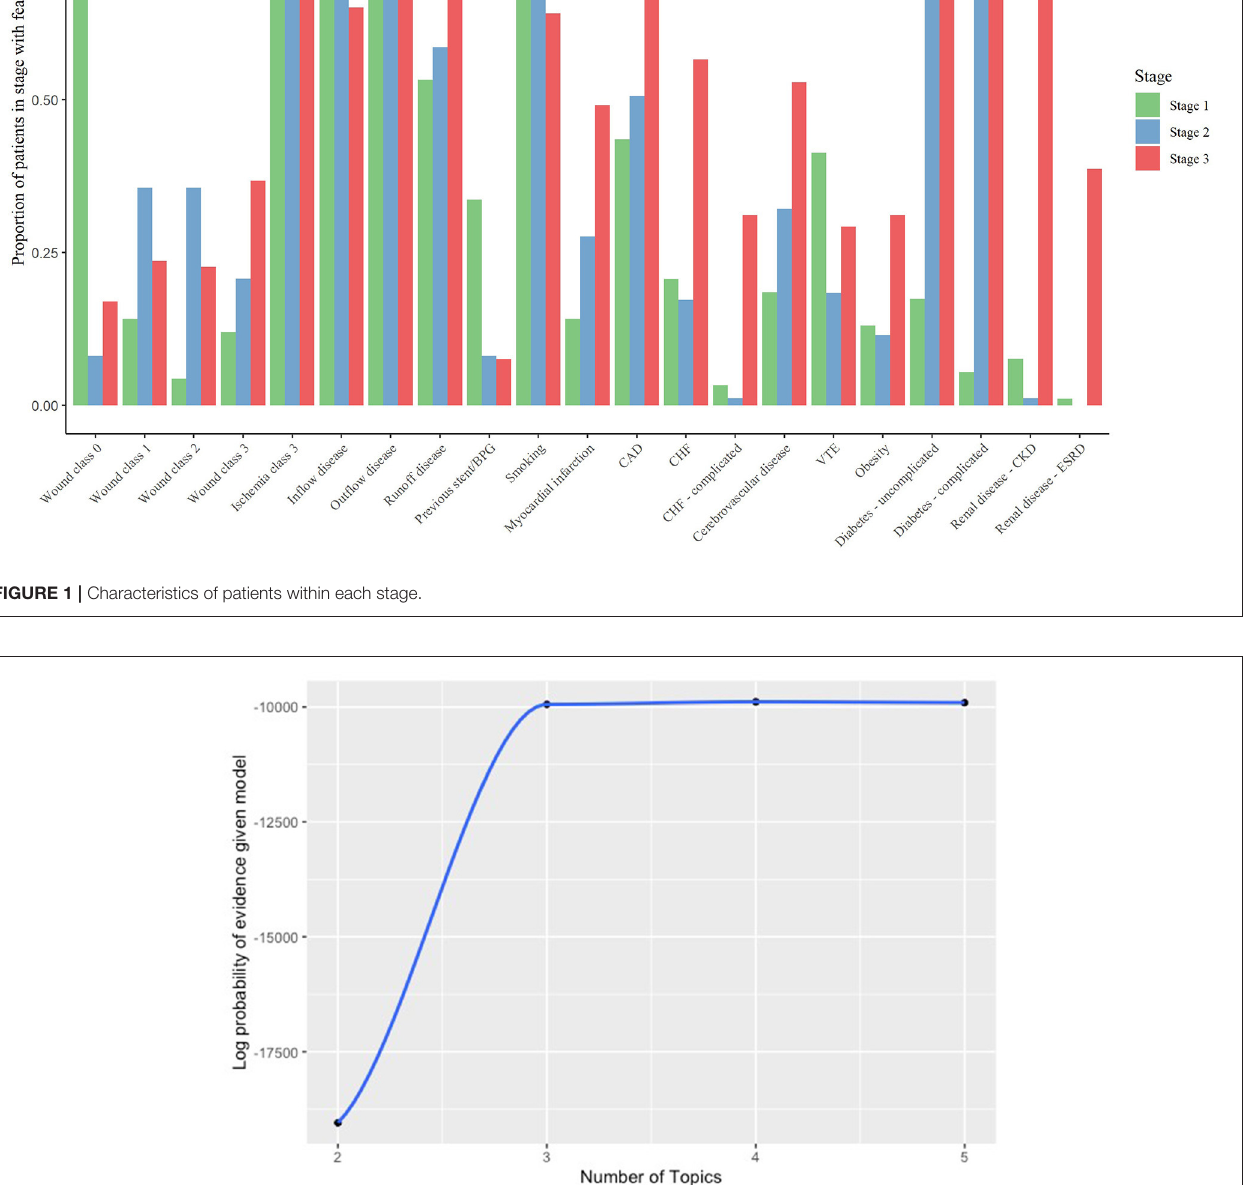
comorbid but did have a higher prevalence of smoking (85%), COPD (47%), venous thromboembolism (41%), and venous insufficiency (22%). However, stage I patients were